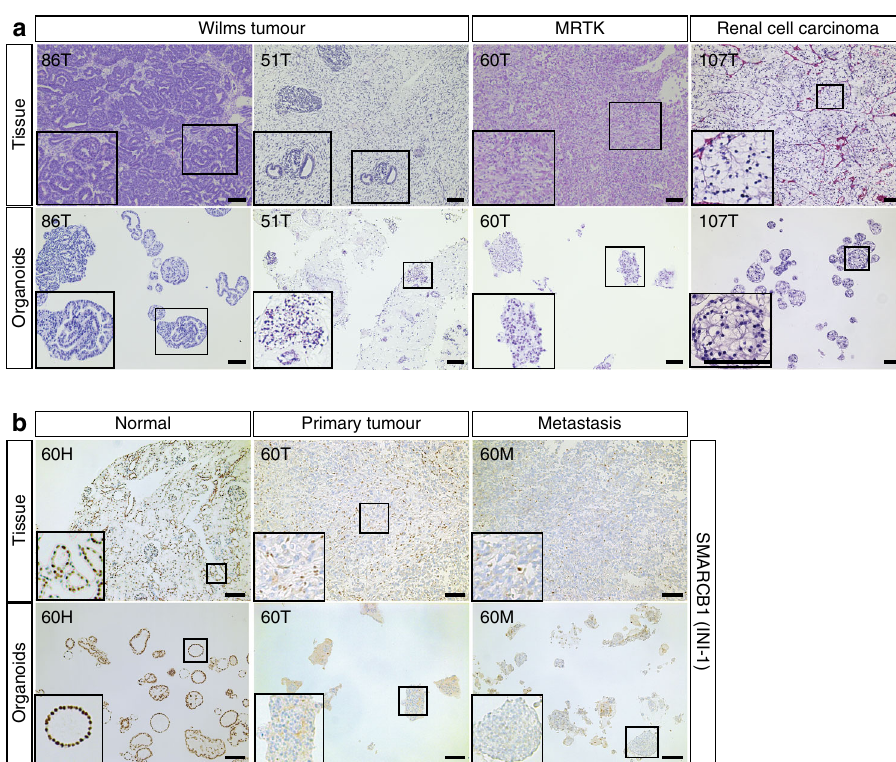
Fig. 2 Histologic characterisation of paediatric kidney cancer organoids. a H&E staining on tissue (top) and matching organoids (bottom) derived from the indicated tumour types ( n = 3). Additional cases can be found in Supplementary Fig. 2. Scale bars: 100 µ m, zoom in 50 µ m. b Representative SMARCB1 staining on normal (left), primary tumour (middle) and metastasis (right) tissue (top) and matching organoids (bottom) of a patient with a MRTK ( n = 3). Of note, immune cells stain positive for SMARCB1 in MRTK tissue. Additional cases can be found in Supplementary Fig. 3. Scale bars: 100 µ